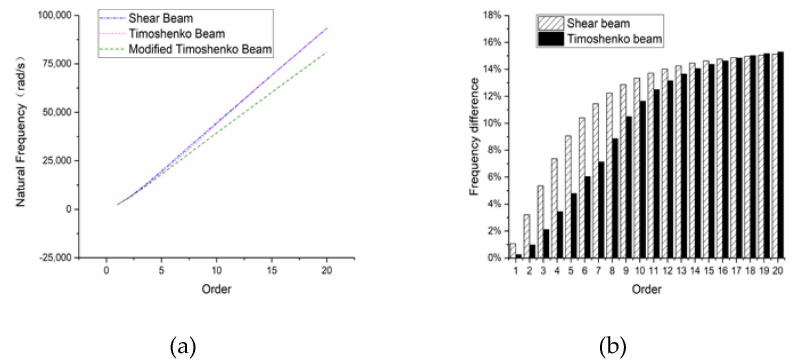
Figure 26. Natural frequencies of the 4-m-long beam: ( a ) overall frequency curve and ( b ) frequency di ff erence compared with a modified Timoshenko beam.